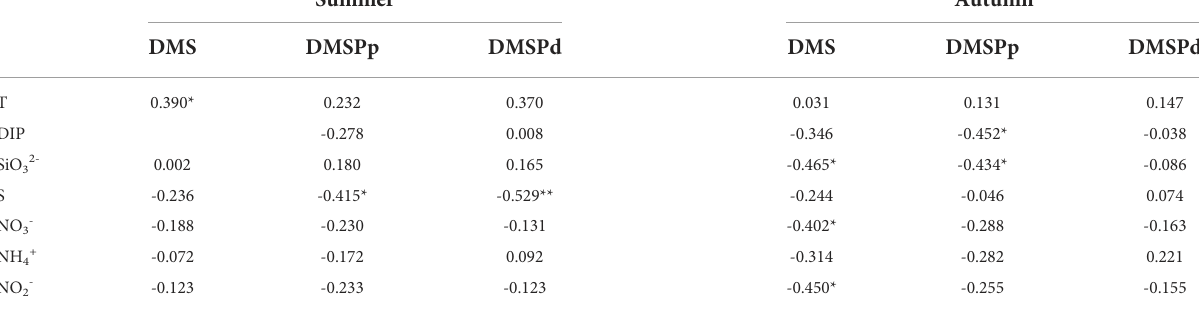
TABLE 2 Correlations among the concentrations of DMS and DMSP and the environment factors in the surface waters of BS and NYS in summer and